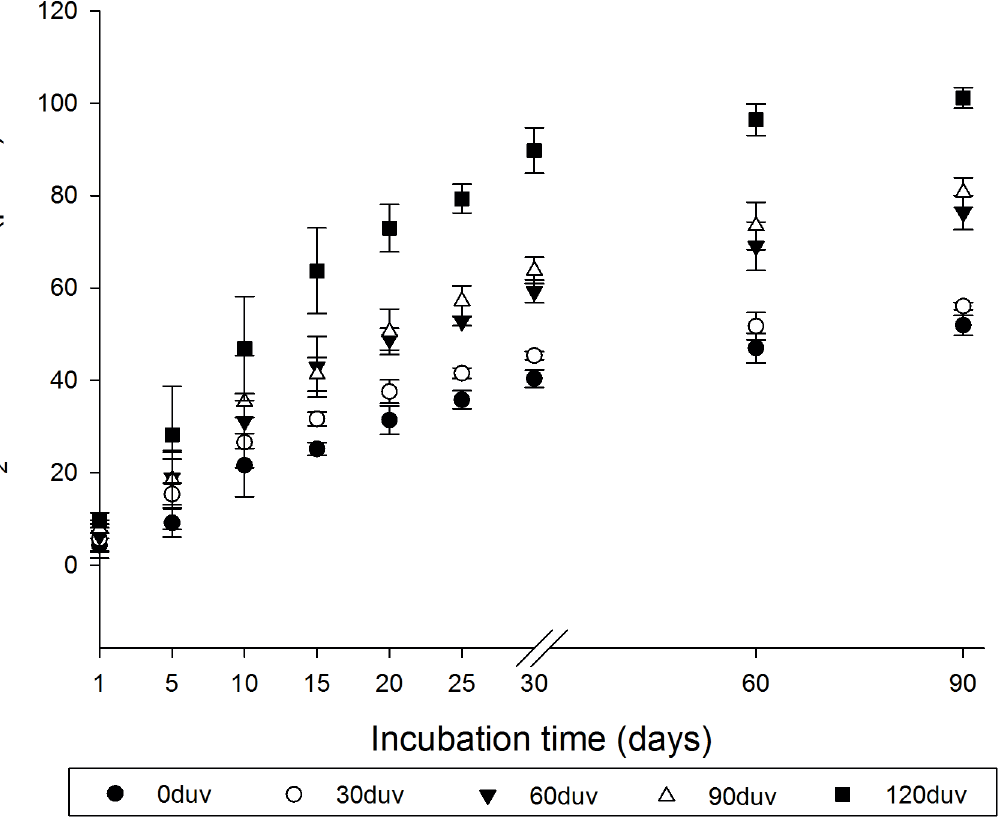
Fig 3. Respiratory activity of Pleurotus ostreatus grown during 90 days in green polyethylene before (Oduv) and after 30 d (30duv), 60 d (60duv), 90 d (90duv) or 120 d (120duv) days of exposure to